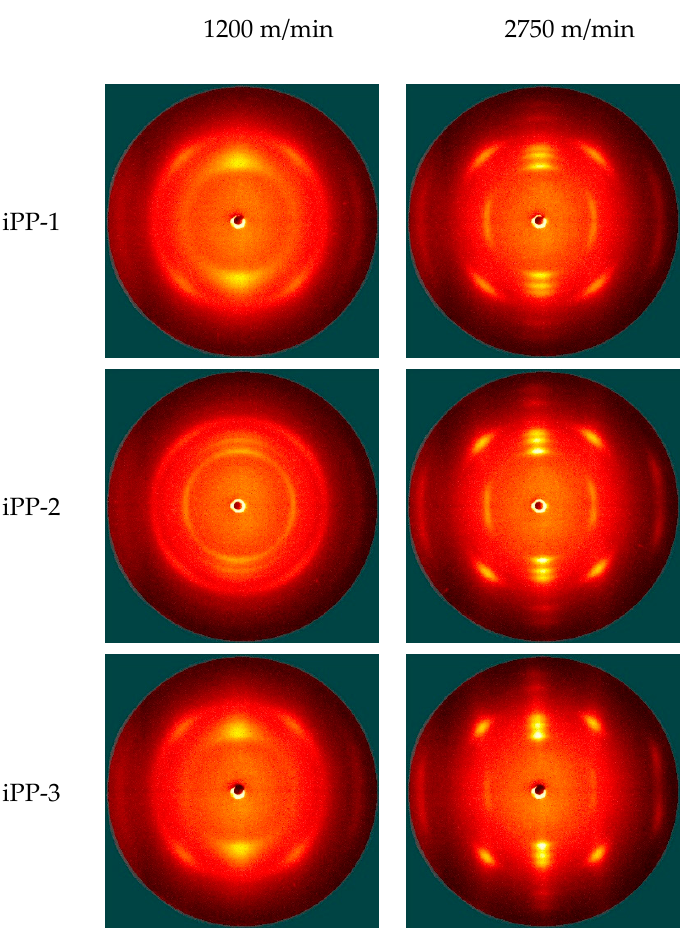
Figure 7. 2D-WAXD patterns of as-spun iPP fibers.